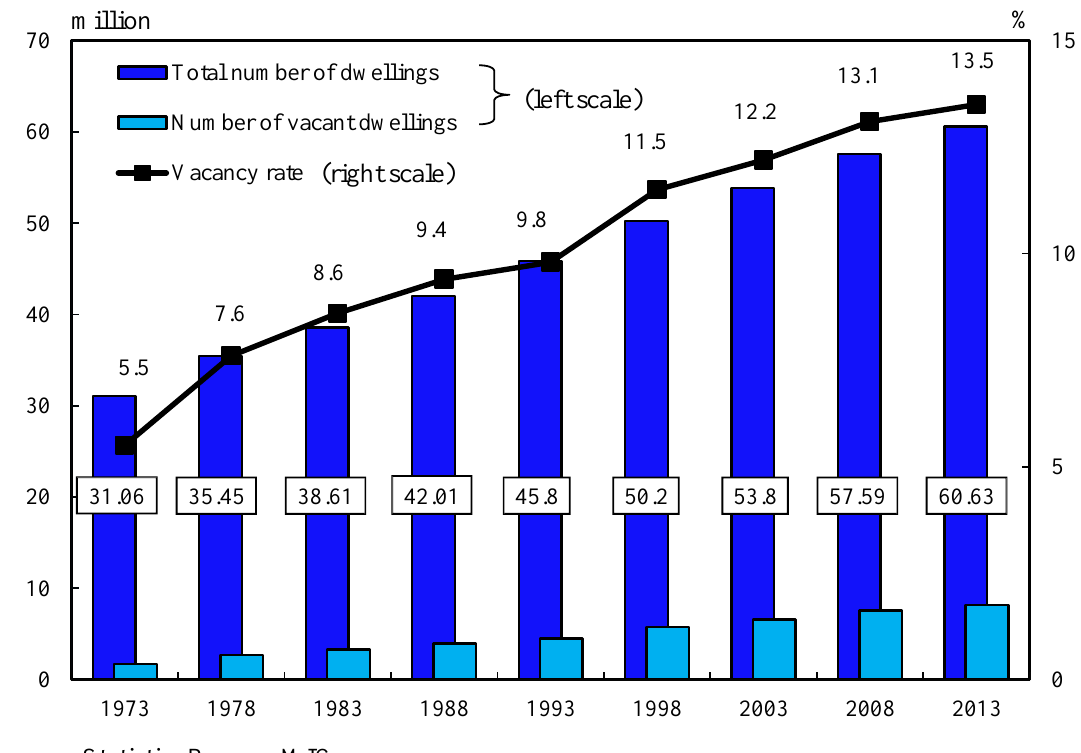
Trends in Dwellings, Vacant Dwellings and Vacancy